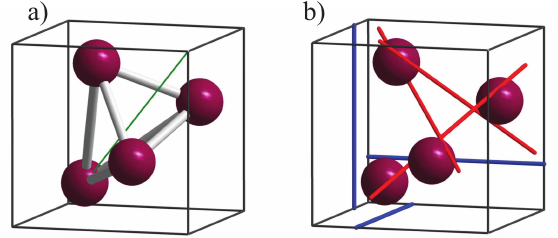
Figure 3. Screw rotations and simple structure in space group 198. ( a ) Arrangement of the atoms on position 4a. ( b ) Position of the 2- (blue) and 3-fold (red) screw axes. The three 2 1 screw axes are parallel to the principle axes. The three 3 2 screw axes are parallel to shown in a) (green diagonal line) is a simple 3-fold rotational axis.